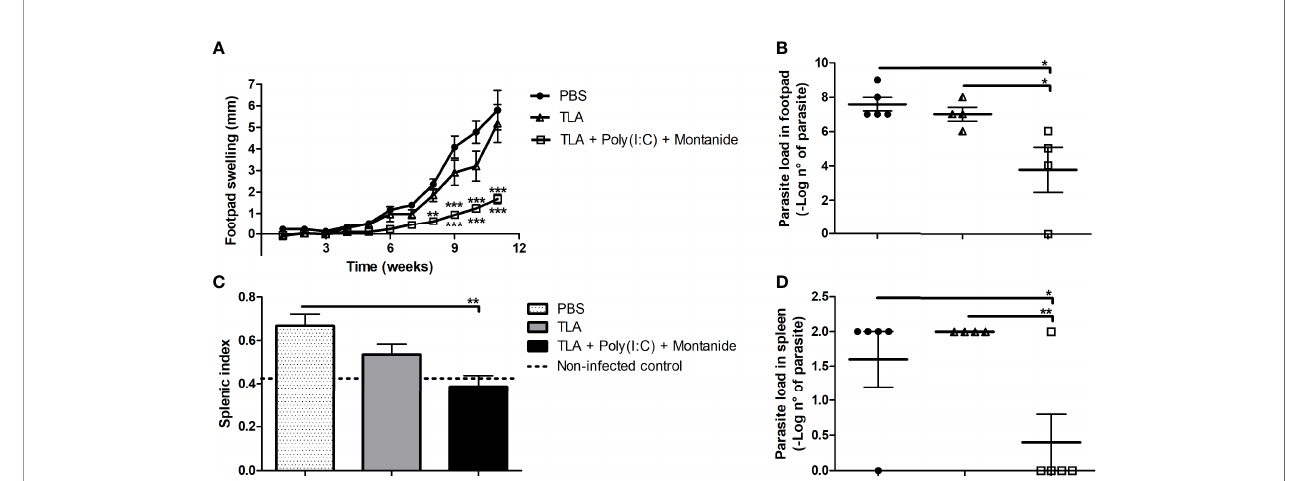
FIGURE 2 | Protectionanalysisinimmunizedmice.Fiveanimalspergroupwereinfectedwith10,000promastigotesof L.amazonensis byintradermicinjection via therightfootpad 14daysafterthelastboost.Footpadswelling(mm)wasmeasuredweeklyuntil11weeksafterinfection;dataarepresentedasthemean±SEM (A) .Parasiteloadwasdetermined bylimitingdilutionintherightfootpad11weeksafterinfection;dataarepresentedasthemean±SEMof – lognumberofparasites (B) .Splenicindexwascalculated11weeksafter infection;dataarepresentedasthemean±SEM (C) .Parasiteloadwasdeterminedbylimitingdilutioninthespleen11weeksafterinfection;dataarepresentedasthemean±SEM of – lognumberofparasites (D) .Asterisksrepresentdifferencesbetweengroups* p <0.05;** p <0.01;*** p <0.001byANOVA (A – C) andKruskal – Wallis (D) tests.